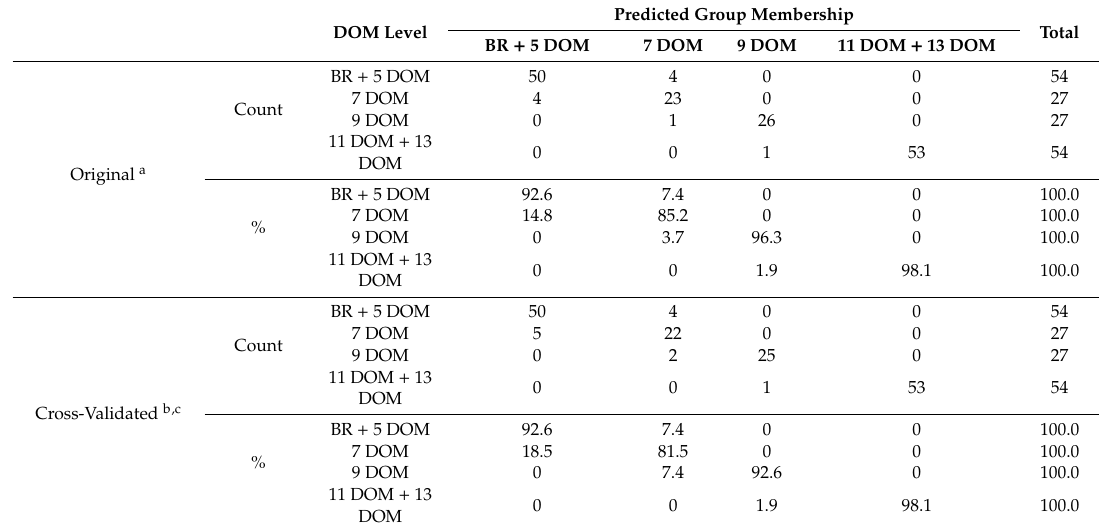
Table 2. Classification and cross-validation results of rice DOMs (4 levels) identified using SDA. DOM